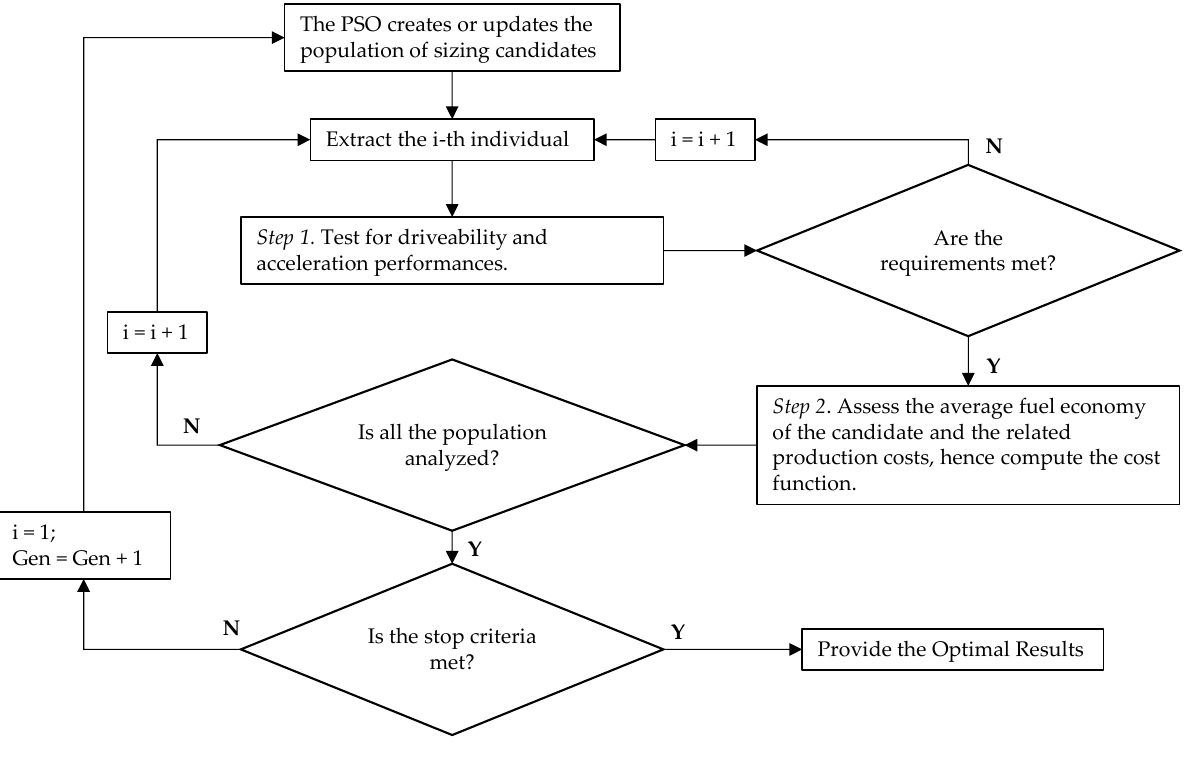
Figure 2. Complete design workflow.